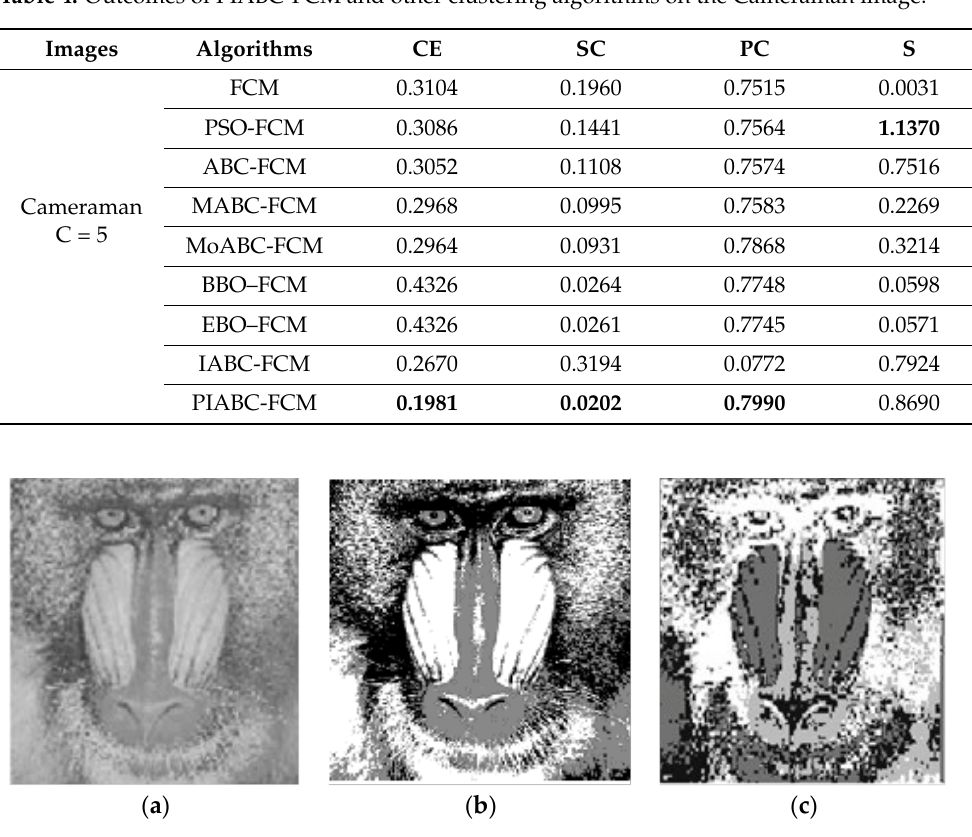
Figure 2. Baboon segmented image: ( a ) original image, ( b ) PIABC-FCM, and ( c ) IABC-FCM.